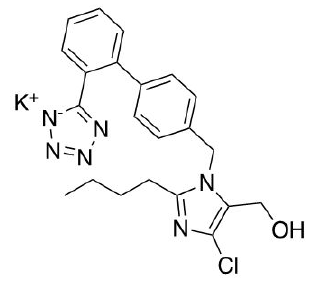
Figure 1. Losartan